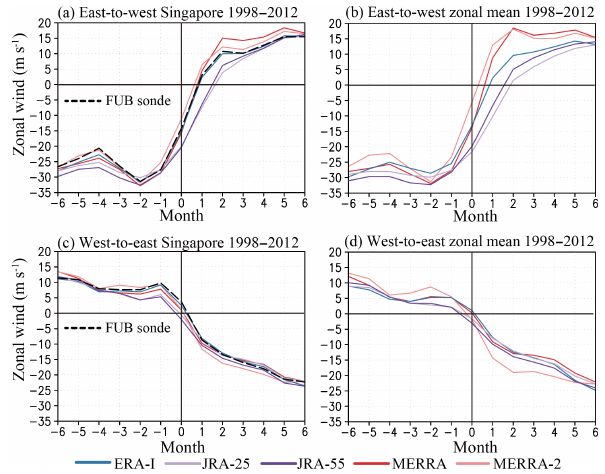
Figure 16. Same as Fig. 9a–d but during 1998 to 2012, excluding ERA-40 and including MERRA-2.